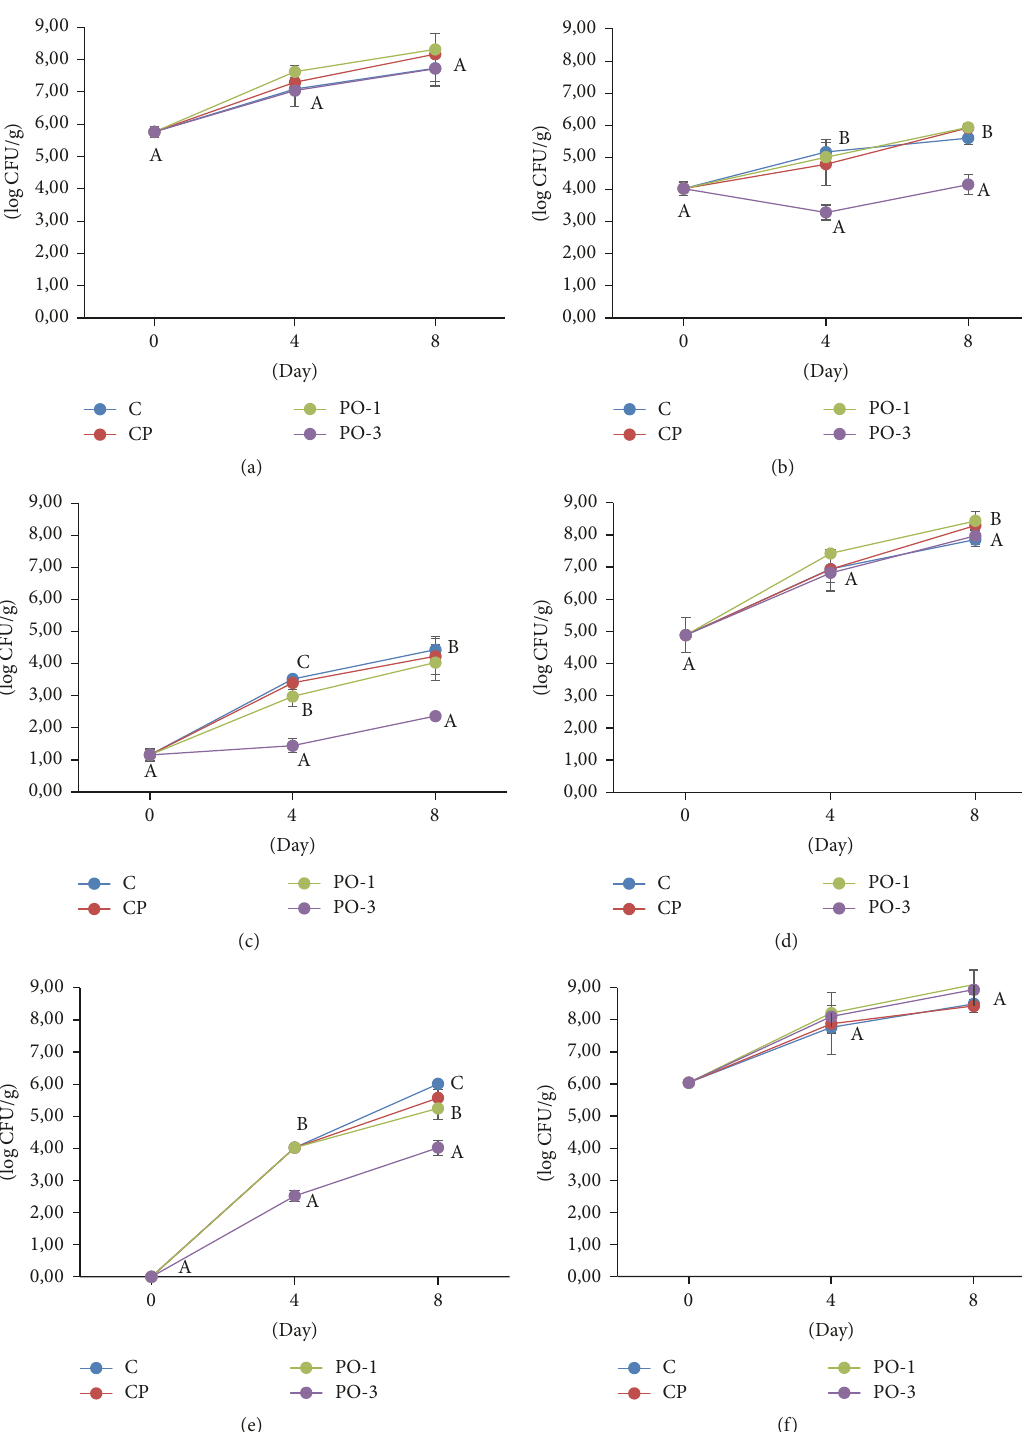
Figure 1: Evolution of the natural microbiota of WPI-Or coated hake fillet stored under air conditions. C: control, CP: control-WPI, PO-1: WPI + Or 1%, and PO-3: WPI-Or 3%. (a) Total viable counts; (b) lactic acid bacteria; (c) Enterobacteriaceae ; (d) psychrotrophic bacteria; (e) H 2 S- producing bacteria; (f)